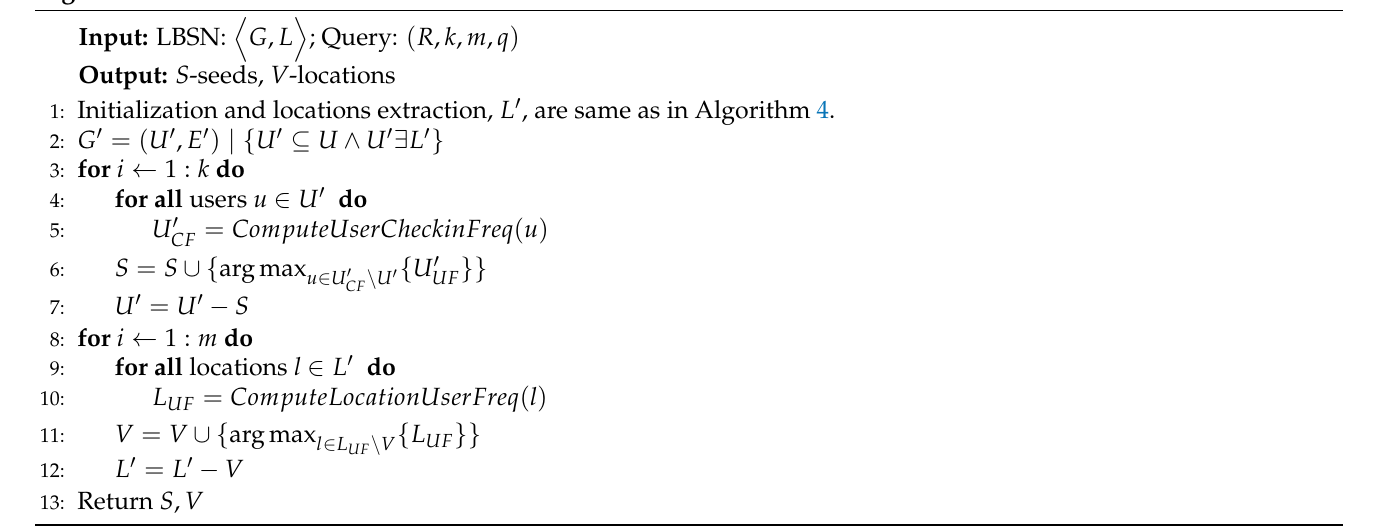
Algorithm 5 t-GIR Selection of influential users and